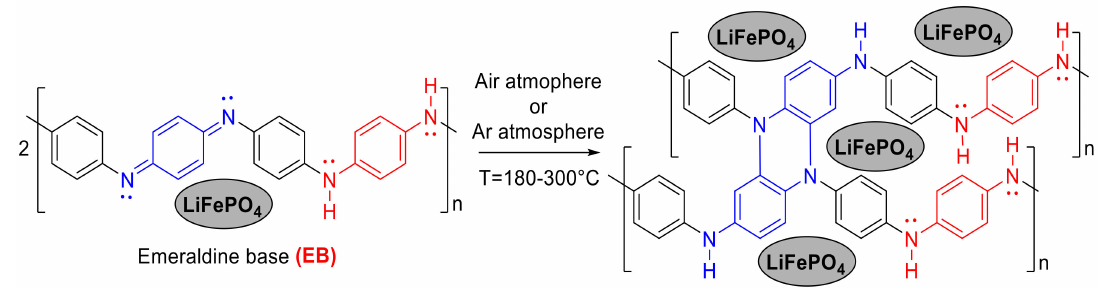
Figure 4. Conversion reaction and structure of crosslinked PANI. A quinoid unit of the PANI chain, shown in blue, reacts with a quinoid unit of another PANI chain, to form crosslinked PANI.